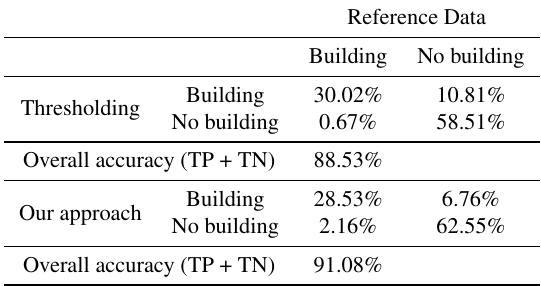
Table 1: Confusion matrices of the results in Fig. 7 and Fig.